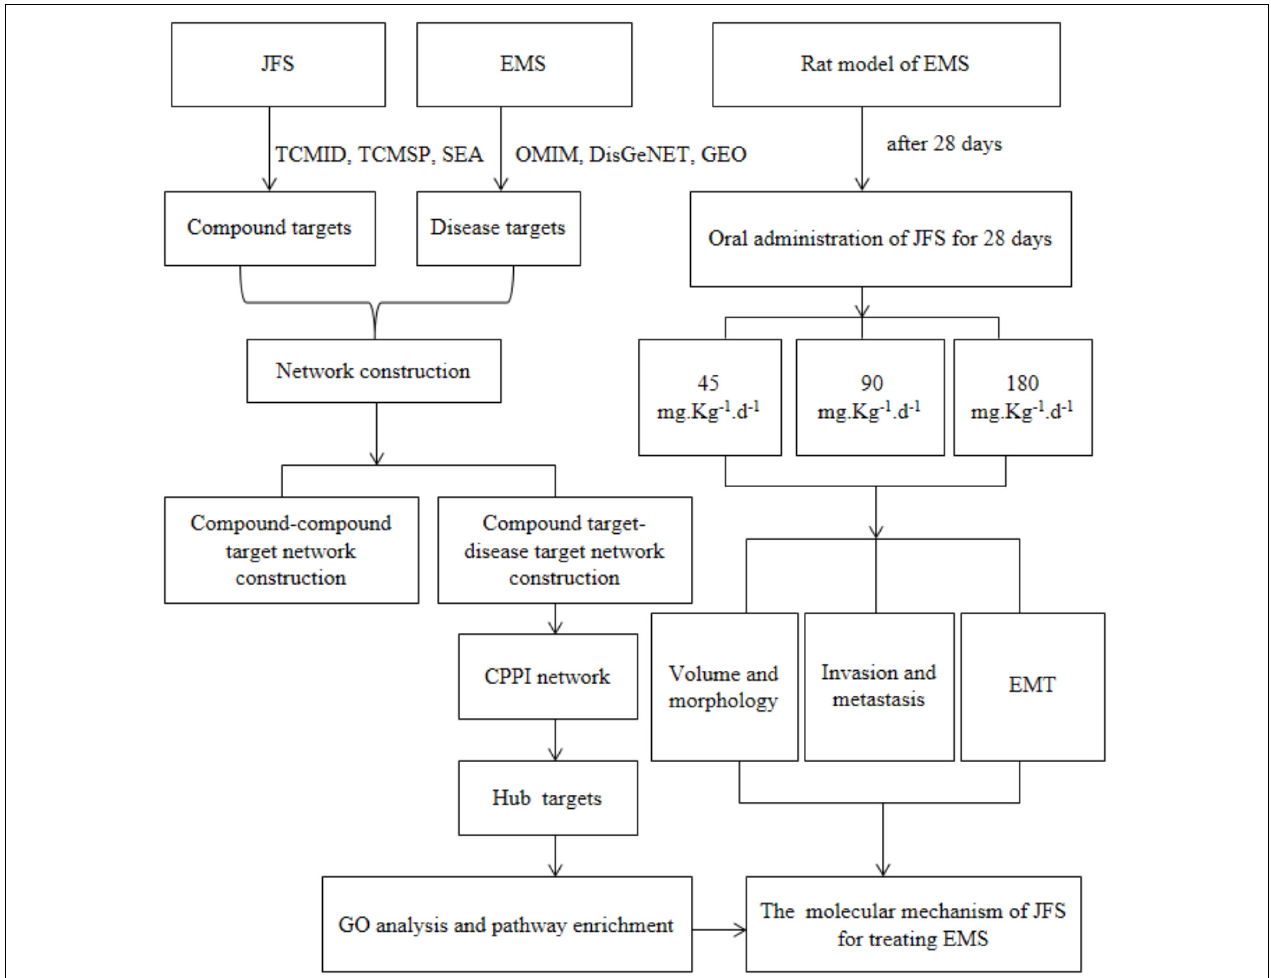
FIGURE 1 | The flowchart of this study based on an integration strategy of network pharmacology and experimental verification. EMS, endometriosis; JFS, Jiawei Foshou San ; TCMID, Traditional Chinese Medicines Integrated Database; TCMSP, Traditional Chinese Medicine Systems Pharmacology Database and Analysis Platform; SEA, Similarity ensemble approach database; OMIM, Online Mendelian Inheritance in Man; DisGeNET, a database of gene–disease associations; GEO, Gene Expression Omnibus; CPPI, core protein–protein interaction.